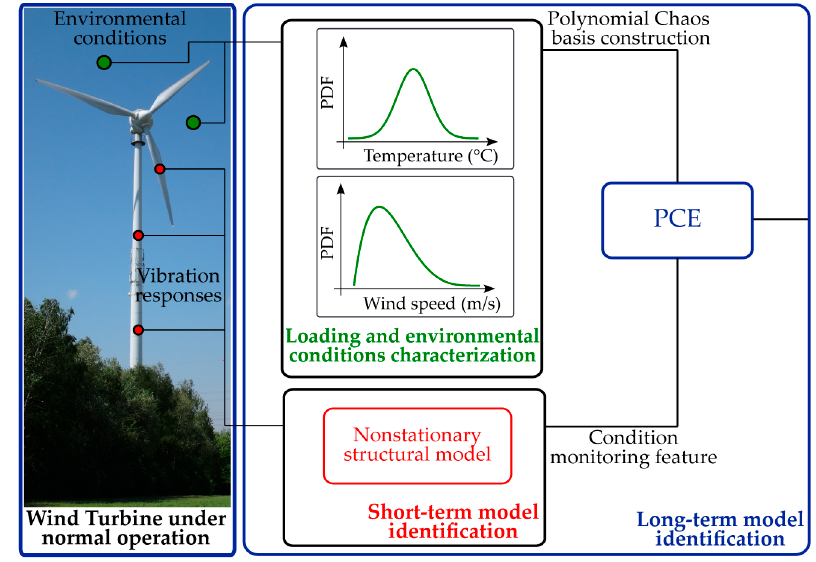
Figure 1. Schematic overview of the proposed bi-component monitoring strategy.